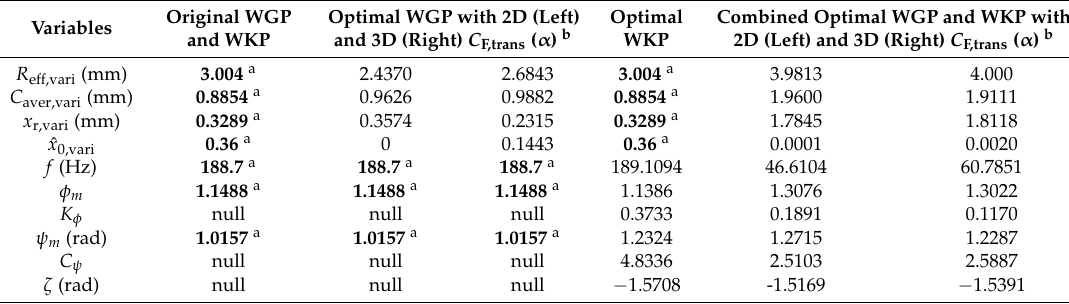
Optimal Combined Optimal WGP and WKP with WKP 2D (Left) and 3D (Right) C F,trans ( α ) b